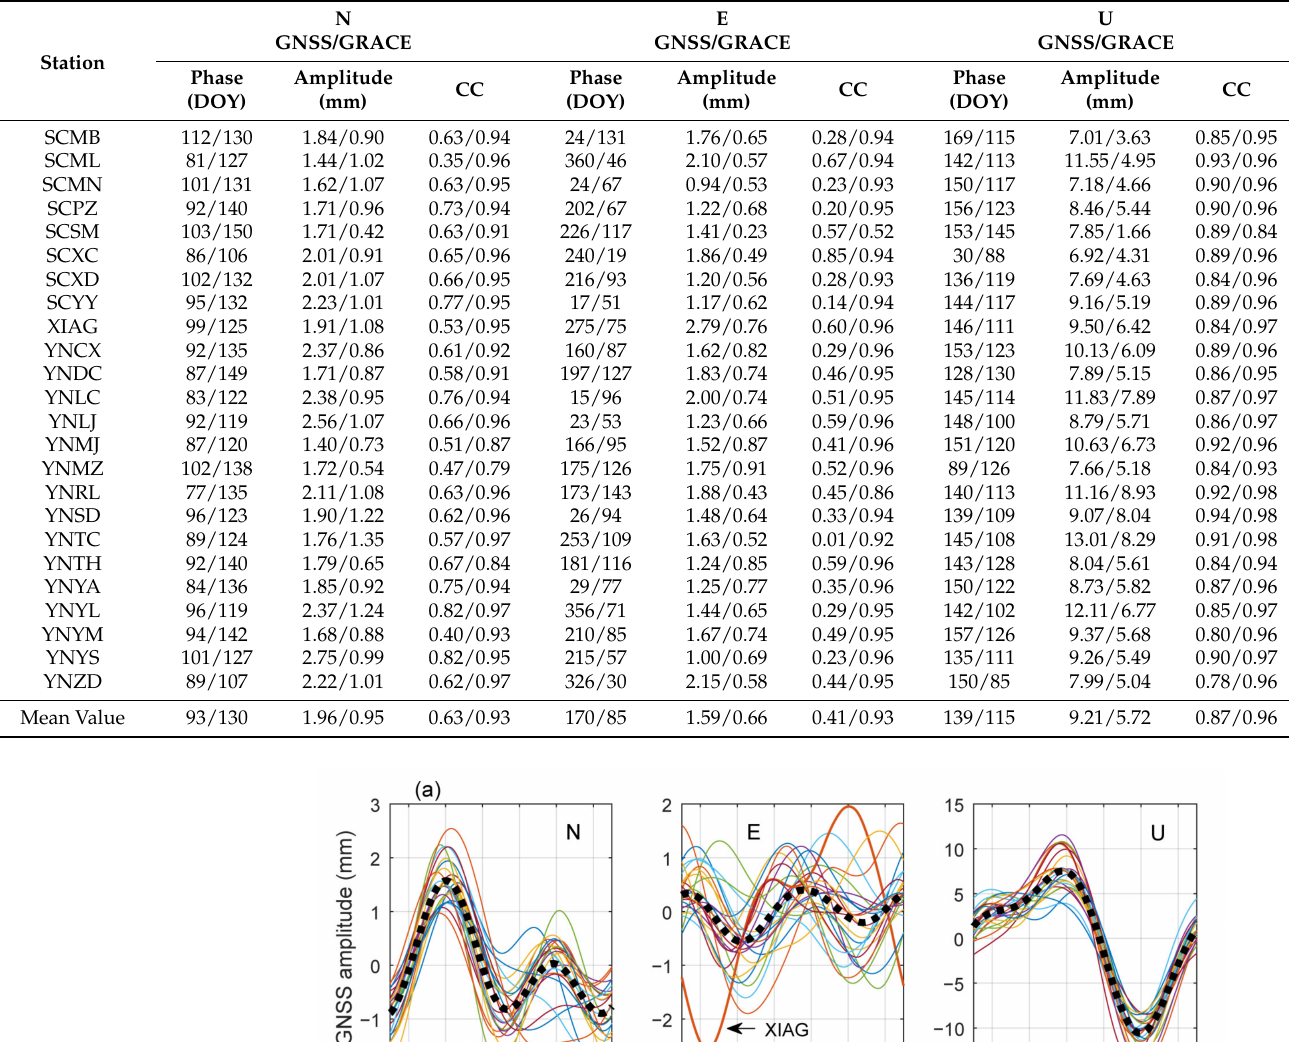
Table 1. Phase, amplitude and CC of seasonal variations of GNSS and GRACE time series for each station.